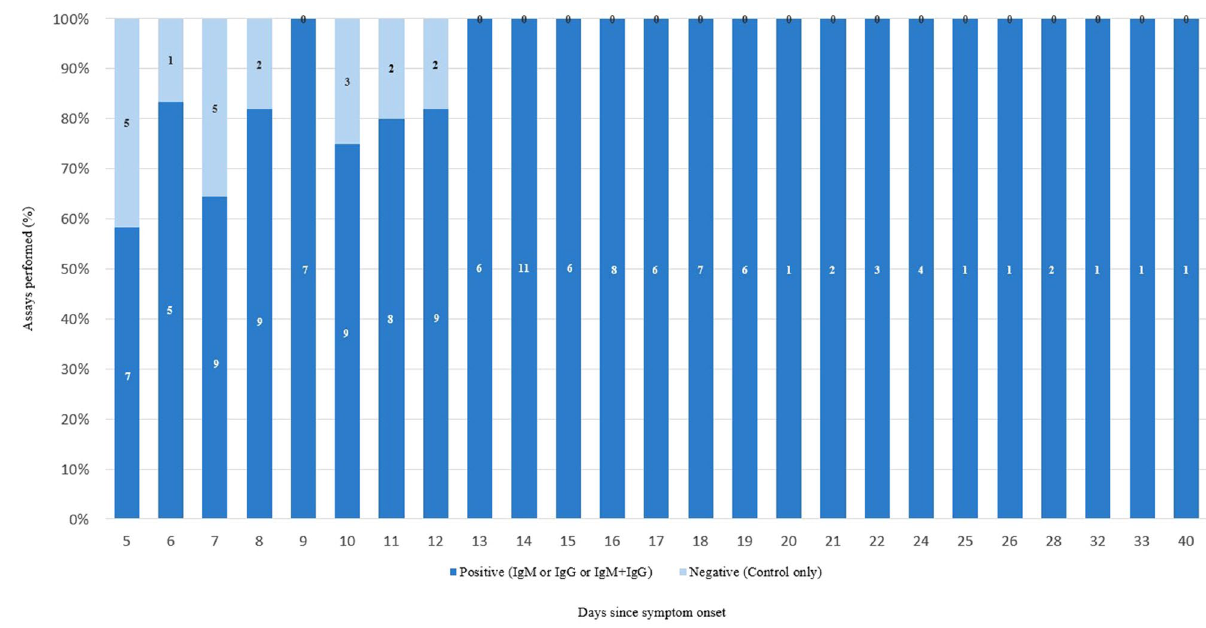
Figure 3. OrientGene point-of-care SARS-CoV-2 serology testing ( n = 200) among inpatients, March–April 2020, London. Assay results against the number of assays performed on each day post-symptom